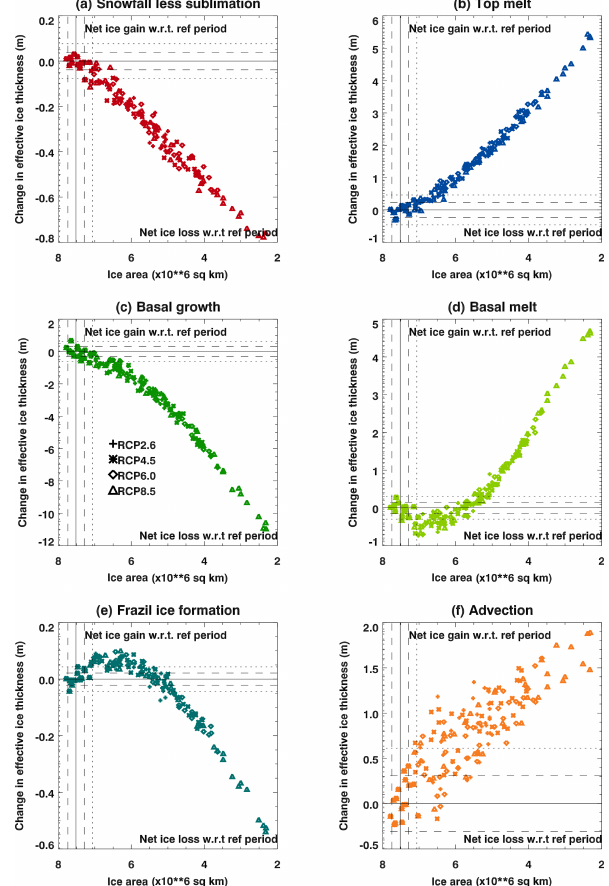
Figure 9. Decadal mean HadGEM2-ES sea ice volume budget com- ponents for each ensemble member and for all the forcing scenarios, plotted as differences relative to the reference period 1960–1989, and as a function of the decadal mean ice area. Positive values cor- respond to net ice gain relative to the reference period. The hori- zontal and vertical dashed and dotted lines show ± 1 and 2 stan- dard deviations as calculated from 250 years of the HadGEM2-ES pre-industrial integration. Note that the plots have different vertical